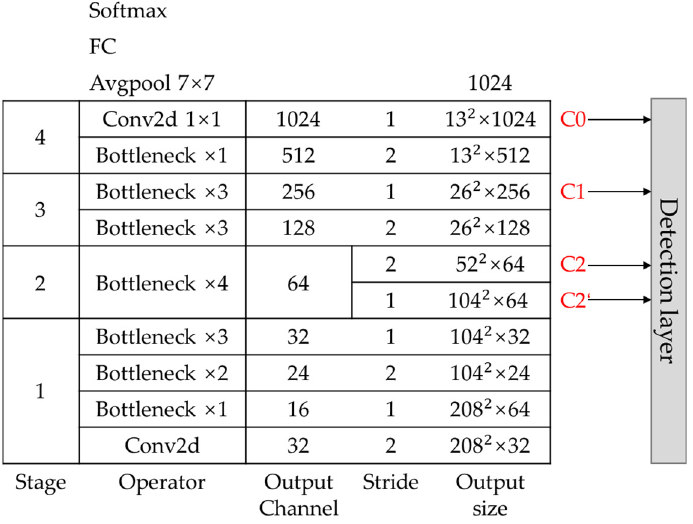
Figure 5. The structure of MobileNetV2 as a feature extractor. Here Ci denotes the feature map from backbone network MobileNetV2. The C2’ and C2 are both derived from the 2nd stage and share the same weights.